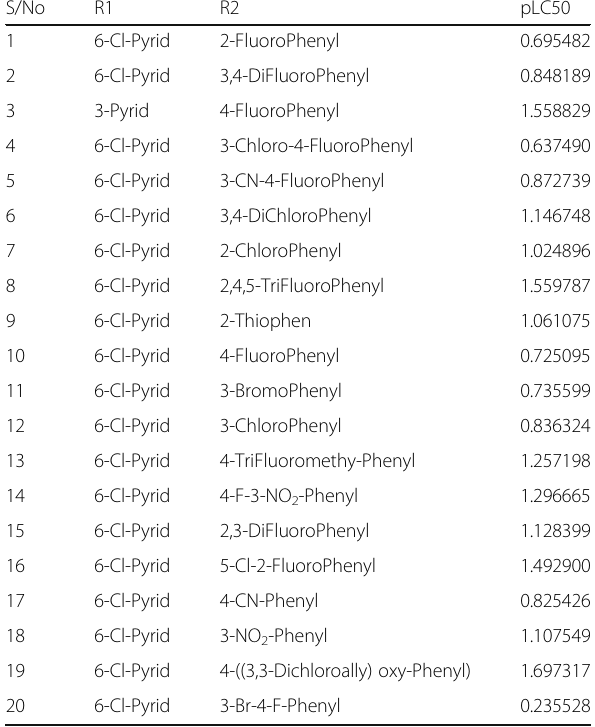
Table 1 Dataset